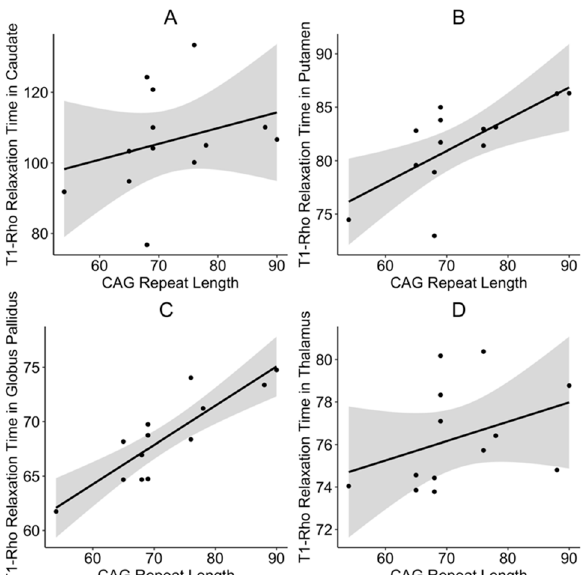
( C ) globus pallidus, and ( D ) thalamus. Results show raw data points, the fitted regression line of